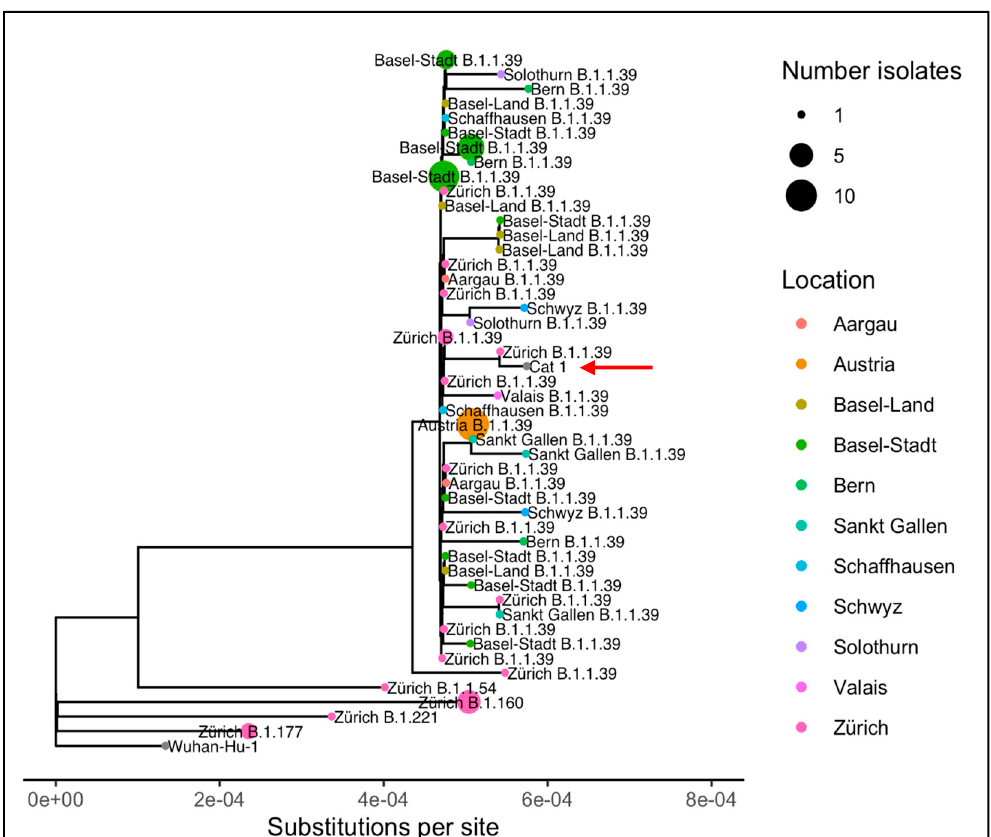
Figure 3. Phylogenetic tree showing the relationship between the isolate from Cat 1 and related isolates from humans (69 most genetically similar isolates from the Global Initiative on Sharing All Influenza Data (GISAID) according to nonsynonymous mutations and ten isolates representative of the predominant lineages circulating in Zurich during November 2020). Clades of isolates from the same pangolin lineage collected in the same location are collapsed [60]. The phylogenetic position of Cat 1 is indicated with the red arrow and gray dot.